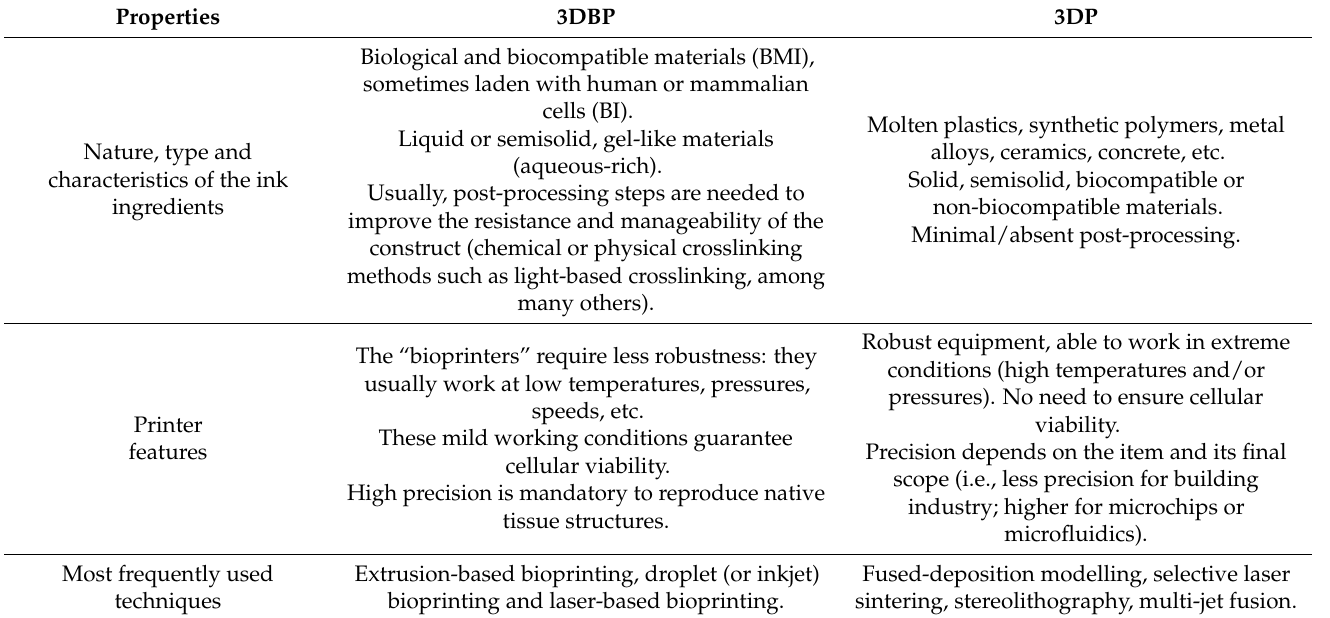
Table 1. Main differences between 3D bioprinting (3DBP) and 3D printing